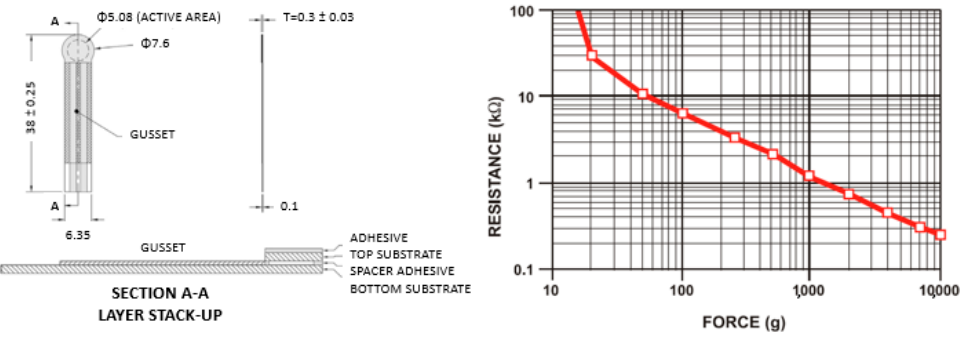
Figure 2. Interlink FSR ® Model 400 mechanical data ( left ) and typical force vs. resistance response ( right ) from the datasheet [14].